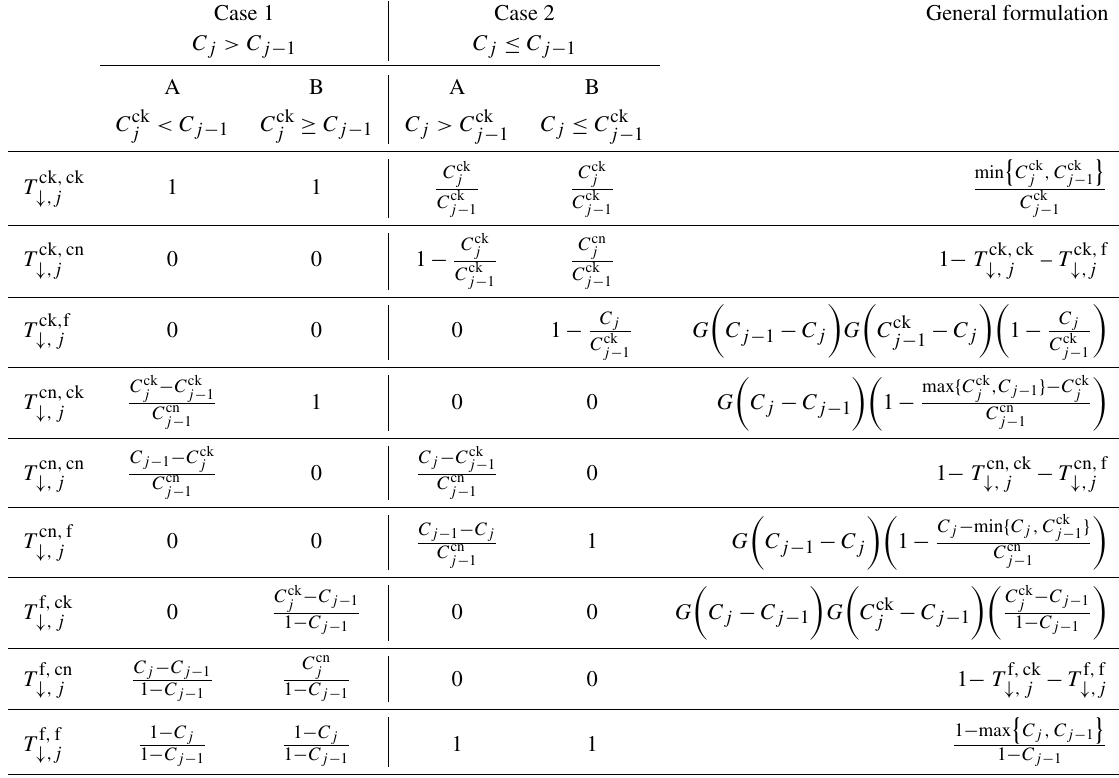
Table B1. The transfer coefficients T a,b ↓ (j) for the four cloud geometric arrangements as well as their general form. Case 1 Case 2 General